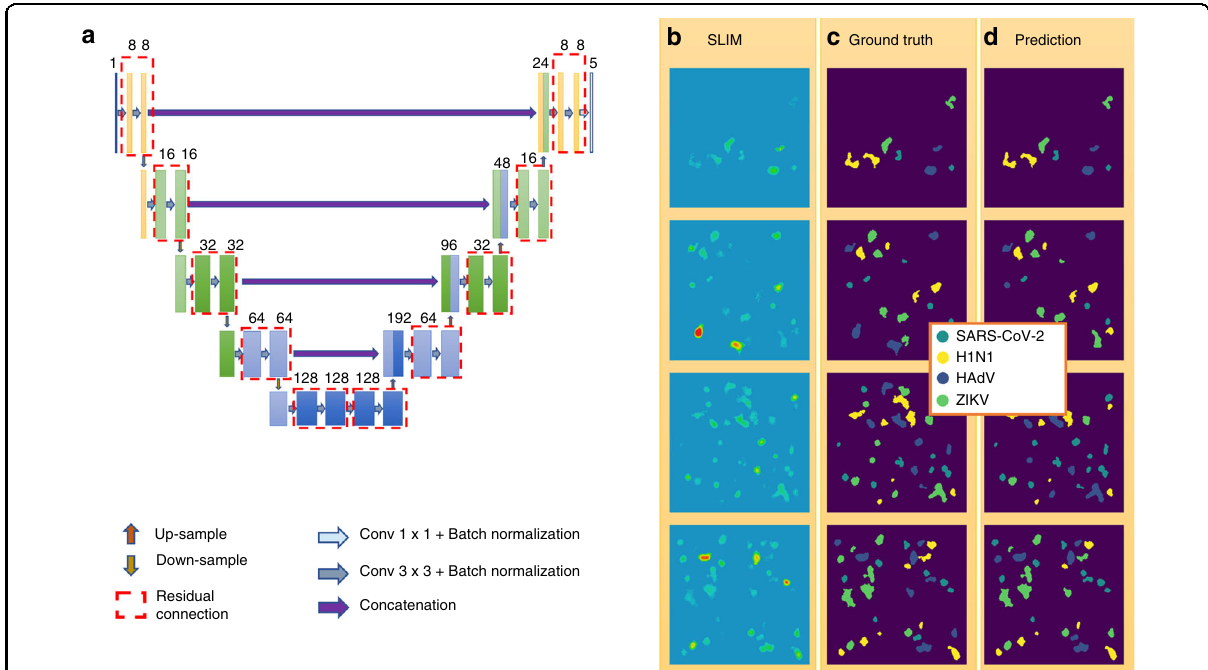
Fig. 5 Training a deep neural network to perform classi fi cation of virus particles for the second dataset. a We used a modi fi ed version of U-Net for this semantic-segmentation task. Besides reducing the number of parameters in the network to around 0.8 million, we also added in residual connection and batch normalization for faster convergence. Model inference on images from the test set. b Synthesized images of mixed virus particles. c Ground truth label. d Model